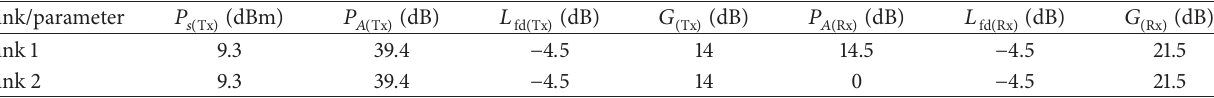
Table 1: Measured values for different parameters in the experimental setup [23].